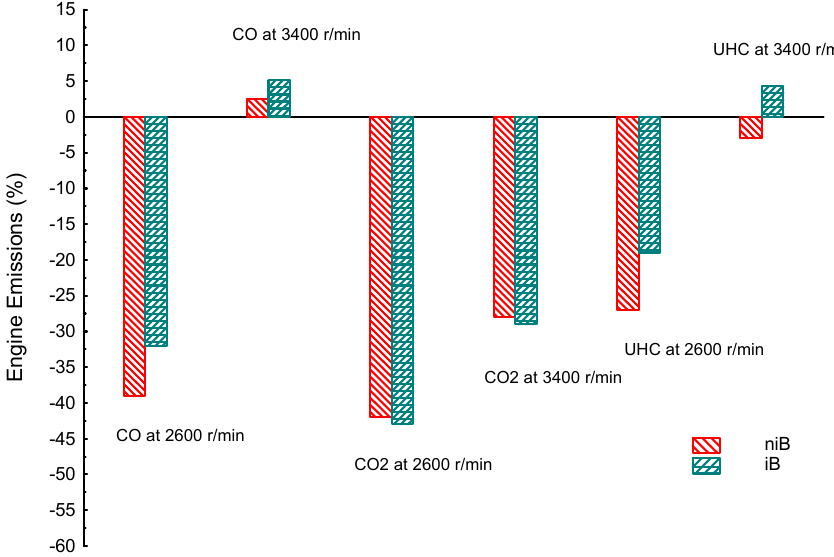
Figure 12. Comparison of CO, CO 2 and UHC emissions for i-butanol–gasoline blends (iB), n-butanol–i-butanol–gasoline blends (niB) and neat gasoline (baseline) at two different speeds.